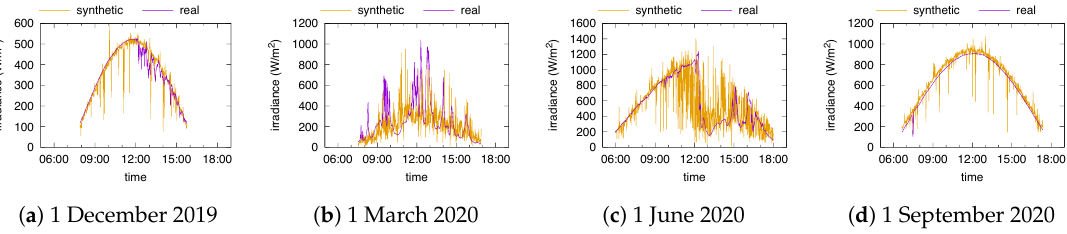
Figure 11. Global irradiance in Golden: measured and synthetic (16 types and 12 intervals).